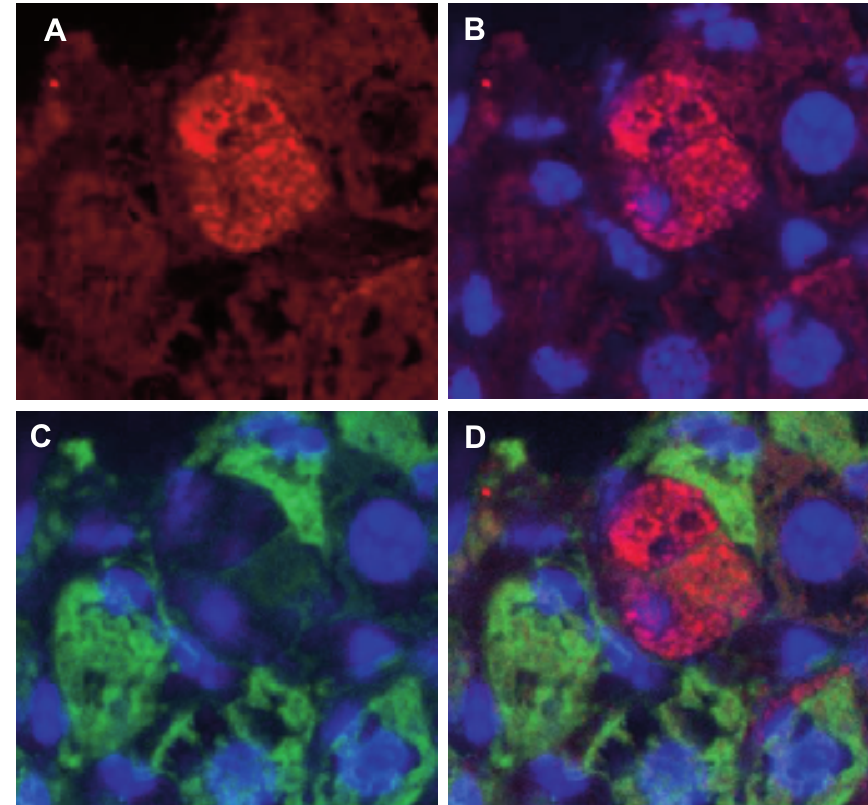
Engraftment of cultured human islet- derived cells into mouse liver. Fluores- cence-immunohisto- chemistry with human and mouse specific antibodies against albumin using confocal micro- scopy with 630 fold